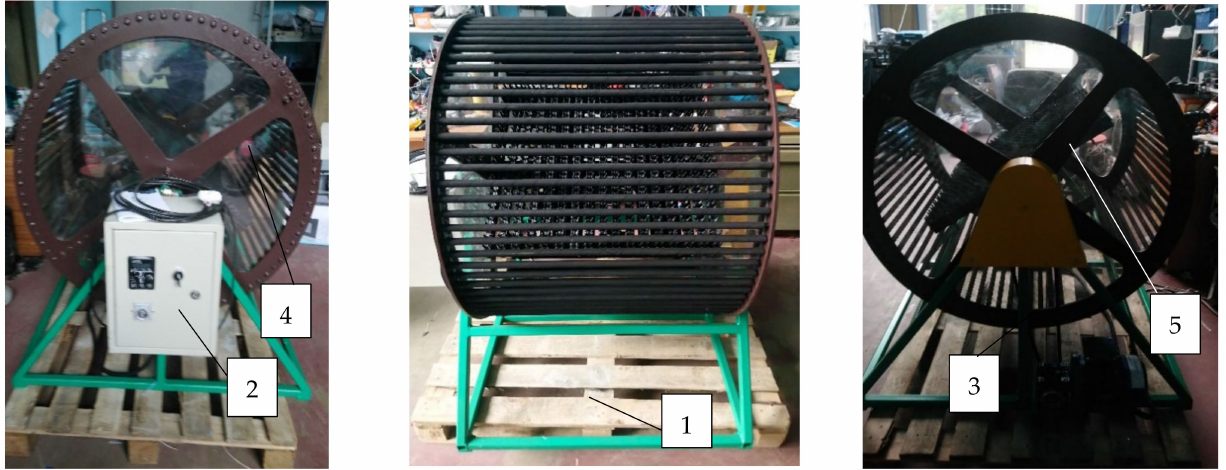
Figure 9. General view of the device for evaluation of suitability of potato varieties and hybrids for mechanized harvesting: 1—support platform; 2—control cabinet; 3—drum; 4—data logger; 5—pin